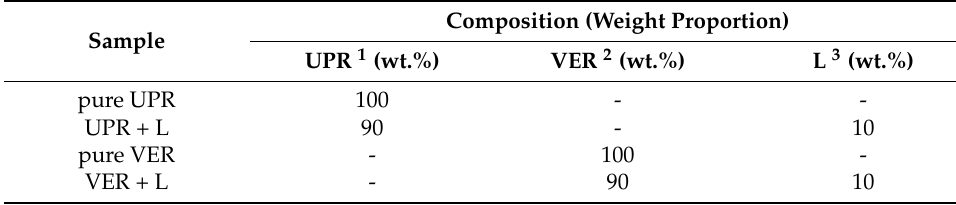
Composition (Weight